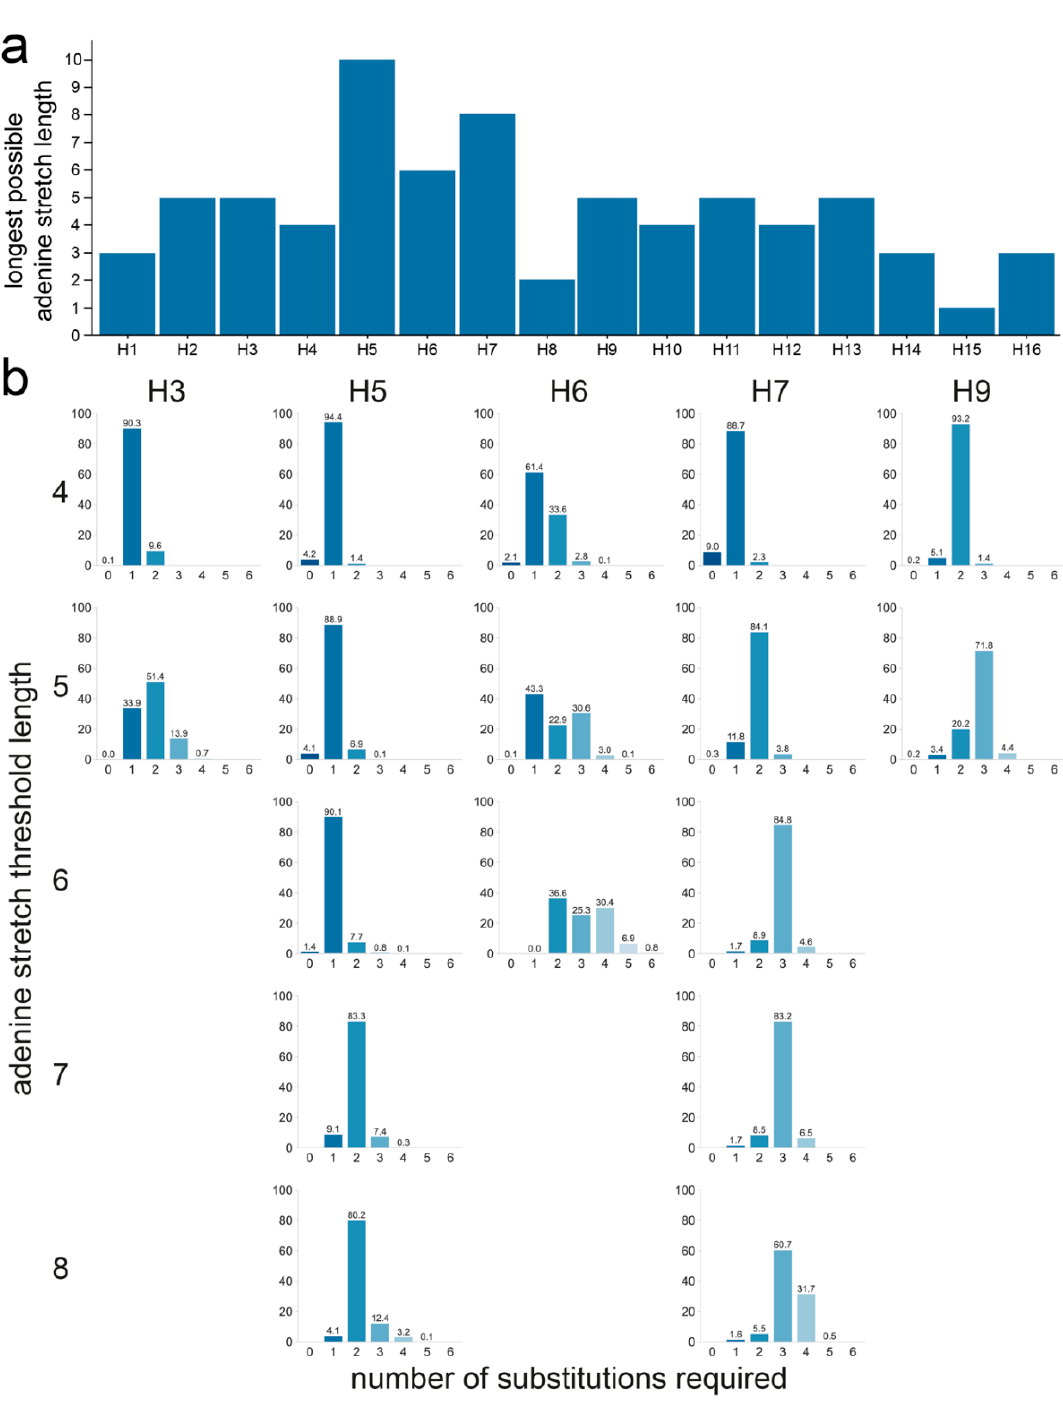
Figure 7. Number of substitutions required to increase adenine stretch length in the P4 to P1 region using only codons found in the dataset at each given position in each subtype. ( a ) Longest adenine stretch achievable with the codon usage of each subtype. ( b ) Number of substitutions required for different adenine stretch lengths for H3, H5, H6, H7, and H9 HAs. For each sequence, the number of substitutions required to obtain a 4- to 8-adenine stretch is shown. The absence of a graph denotes the impossibility of obtaining an adenine stretch of the indicated length using only codons observed in nature. The percentage of sequences needing a given number of substitutions was calculated independently for each subtype. A darker shade of blue indicates that fewer substitutions are required, and the exact percentage is given above each bar.